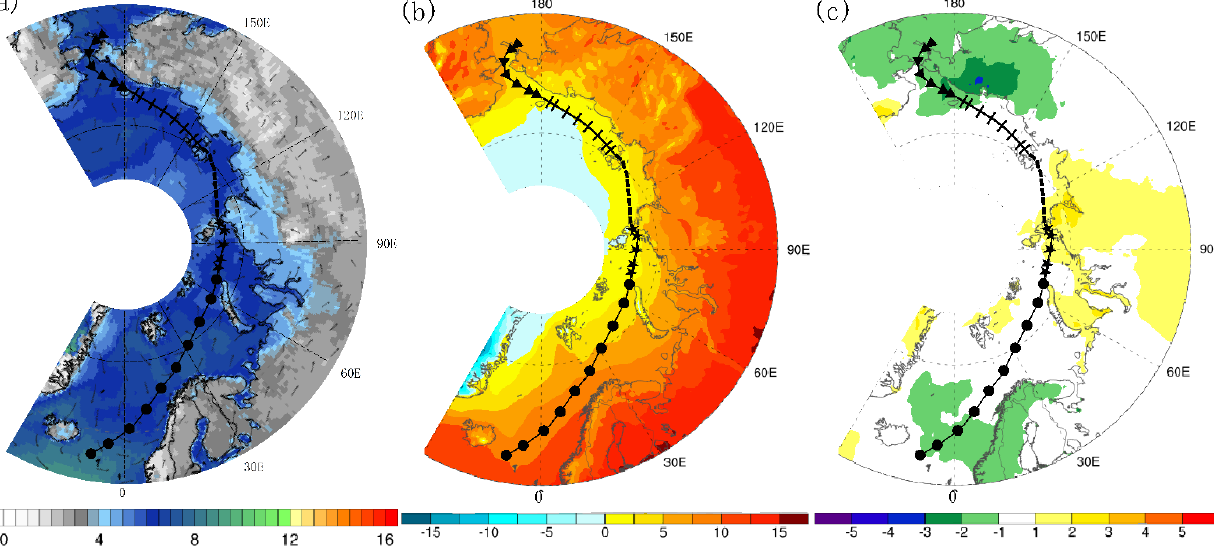
Figure 20. The average wind field ( a ), average temperature ( b ), and temperature anomalies ( c ) of the NEP in the Arctic summer in 2012.